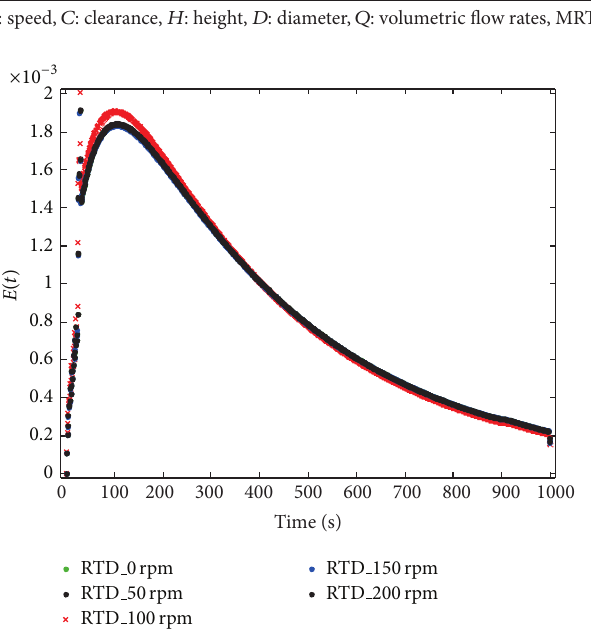
Figure 4: Effects of impeller speed on